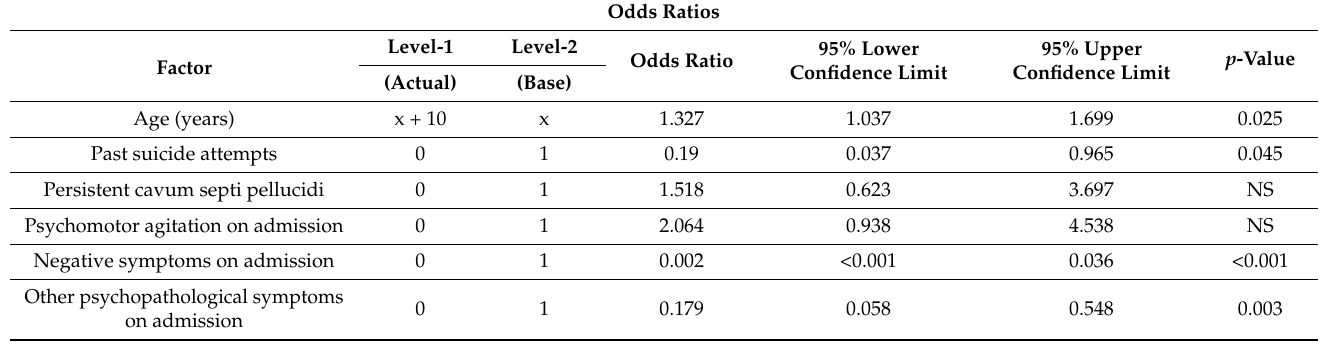
Table 3. Multivariate model—odds ratio values for the parameters affecting the presence of nega- tive symptoms at hospital discharge.